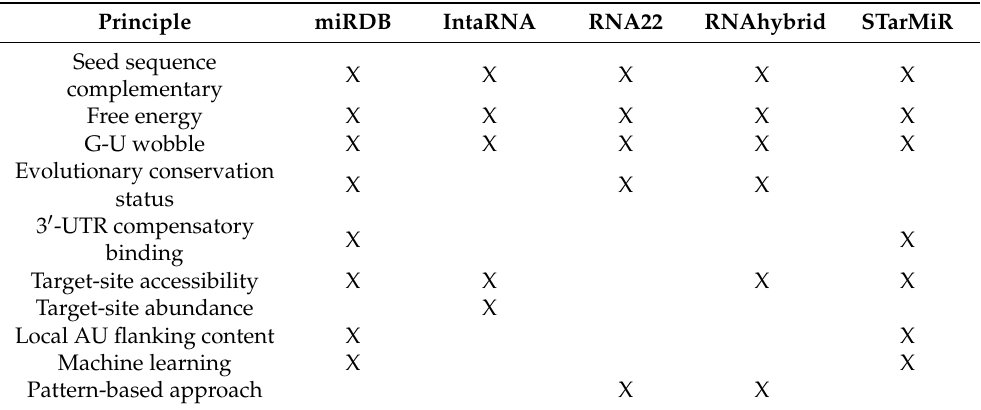
Table 3. Principles used for computational microRNA prediction on which miRDB, IntaRNA, RNA22, RNAhybrid, and STarMir are based. Based on [19,67,68]. Principle miRDB IntaRNA RNA22 RNAhybrid